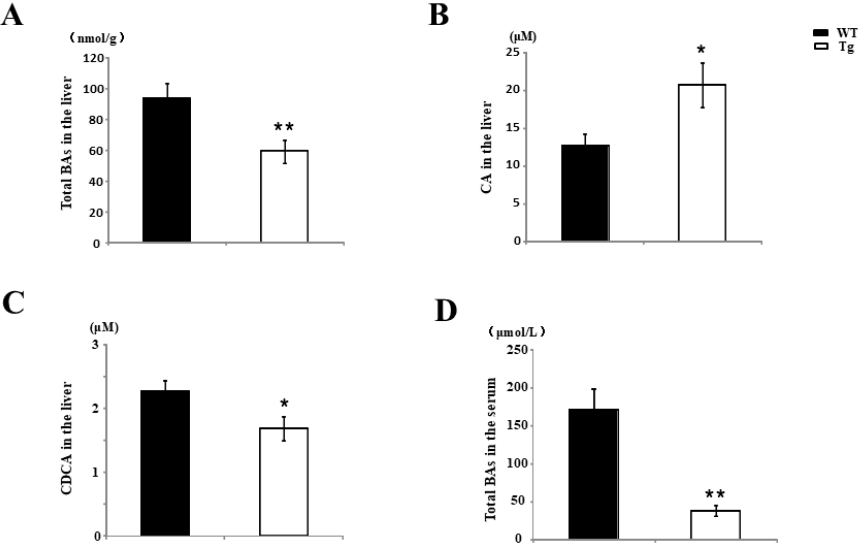
Figure 7. Changes of BA metabolism in Tg mice. The total BA hepatic ( A ) and plasma ( D ) levels in hPRDX4 ‐ Tg mice were significantly lower than in WT mice on day 7 after BDL surgery. The hepatic cholic acid (CA) level was lower while the hepatic chenodeoxycholic acid (CDCA) level was higher in Tg BDL mice than in WT mice. p Values were calculated using Welch’s t ‐ test. The values represent the mean ± SD. * p < 0.05, ** p < 0.001, n = 15.